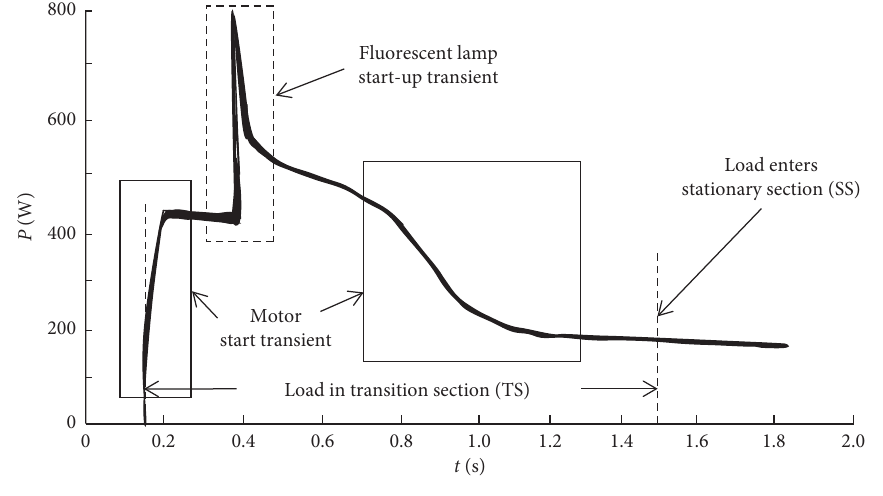
Figure 4: Electrical start-up transient power